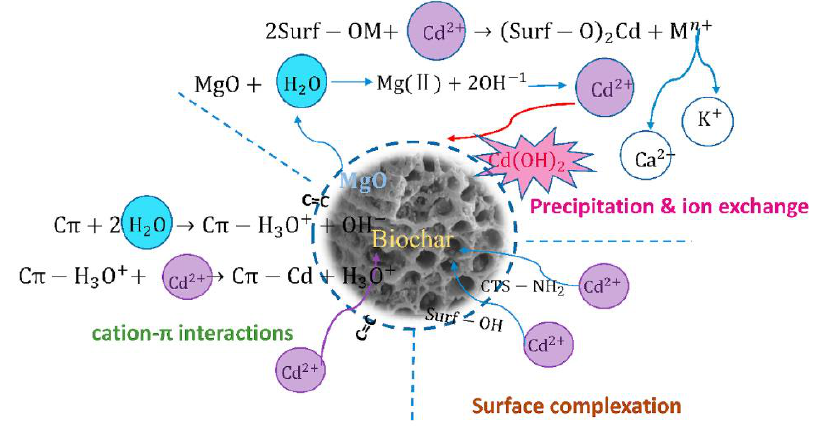
Figure 4. The mechanism diagram of Cd adsorption onto MgO-BCR-W [84].